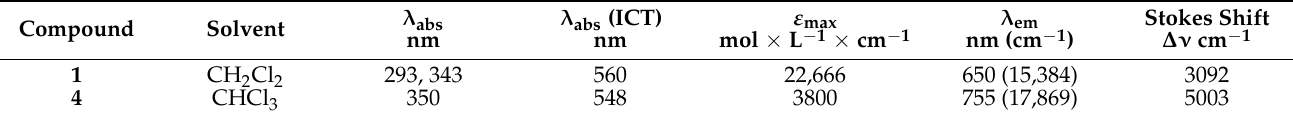
Table 2. Photophysical parameters obtained for 4,4 (cid:48) -([1,2,5]thiadiazolo[3,4- d ]pyridazine- 4,7-diyl)bis( N , N -bis(4-methoxyphenyl)aniline) 1 and 4,4 (cid:48) -([1,2,5]thiadiazolo[3,4- d ]pyridazine-4,7- diyl)bis( N , N -diphenylaniline) 4 : absorption maximum wavelength λ abs , maximum molar extinction coefficient ε , the wavelength of emission maximum λ em , Stokes shift ∆ ν